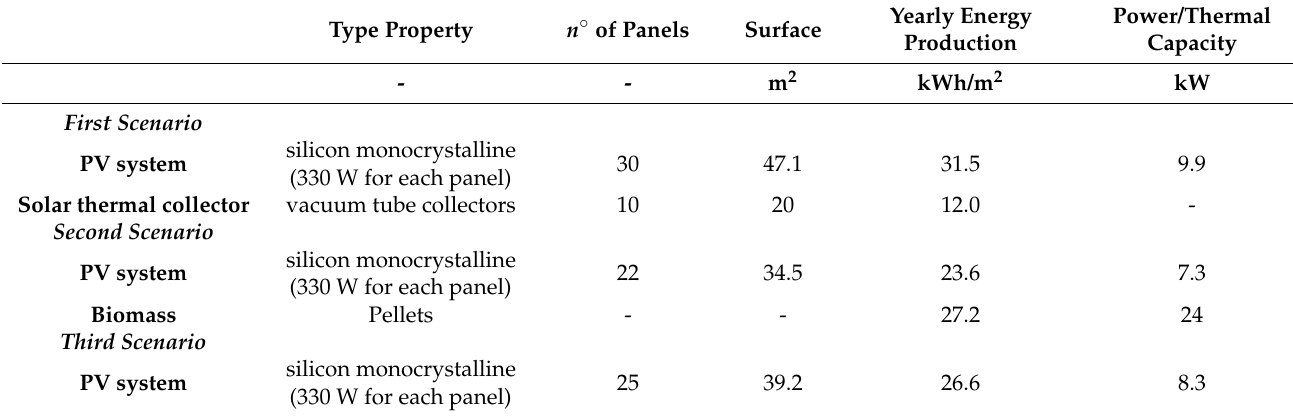
Table 7. Use of renewable energy sources to achieve the NZEB target for the three proposed